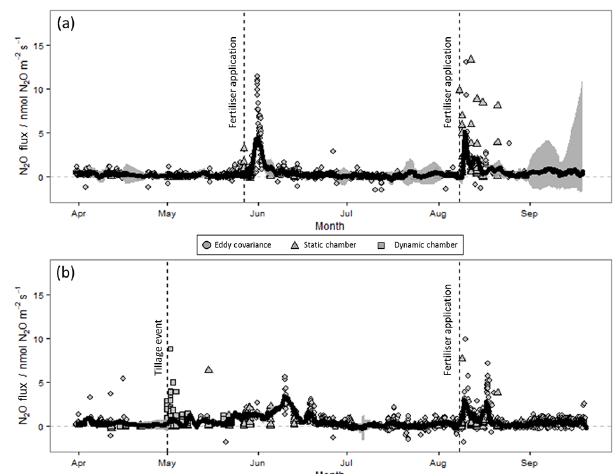
Figure 7. The GAM method (black line) provides an estimated N 2 O flux which can be used to gap-fill measurements from both the (a) untilled and (b) tilled fields at 30min intervals. The 95% confidence interval in the estimated flux reported by the GAM is included (grey). Tillage and fertiliser dates are indicated (vertical